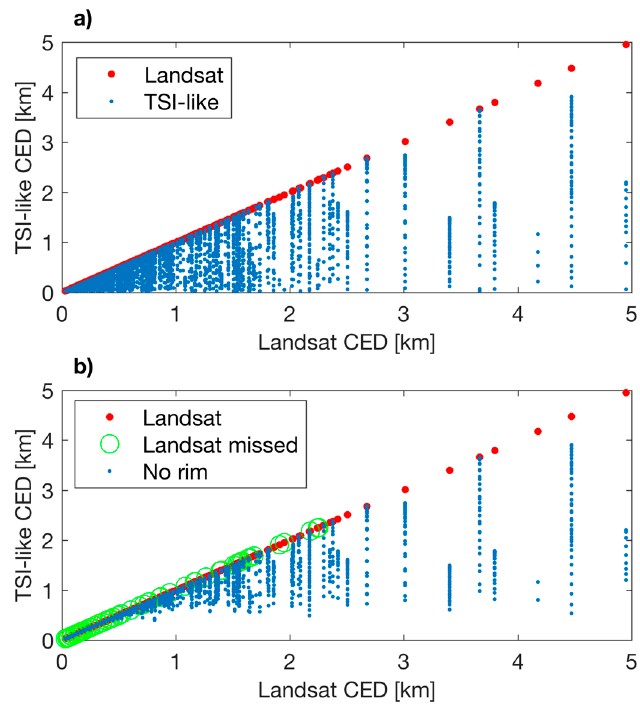
Figure A7. The effect of cloud truncation by maximum FOV and a possible mediating solution. All information is derived from Landsat images. The abscissa shows the full (non-truncated) CED and the ordinate shows multiple observations of each cloud with TSI-like truncation. Clouds from all five Landsat subareas are included as a composite, omitting a single massively merged Landsat cloud from 2017/06/14. ( a ) All observations. 10,101 TSI-like clouds are shown (blue dots), of these 3252 have areas less than the original Landsat, ( b ) The 2076 observations of “rim” clouds have been removed. “Rim” clouds are truncated at a FOV of 130° and exist outside of a 122° FOV. This composite includes 609 unique clouds from the Landsat swath. Removing the “rim” clouds results in censorship of 67 clouds (green circles).